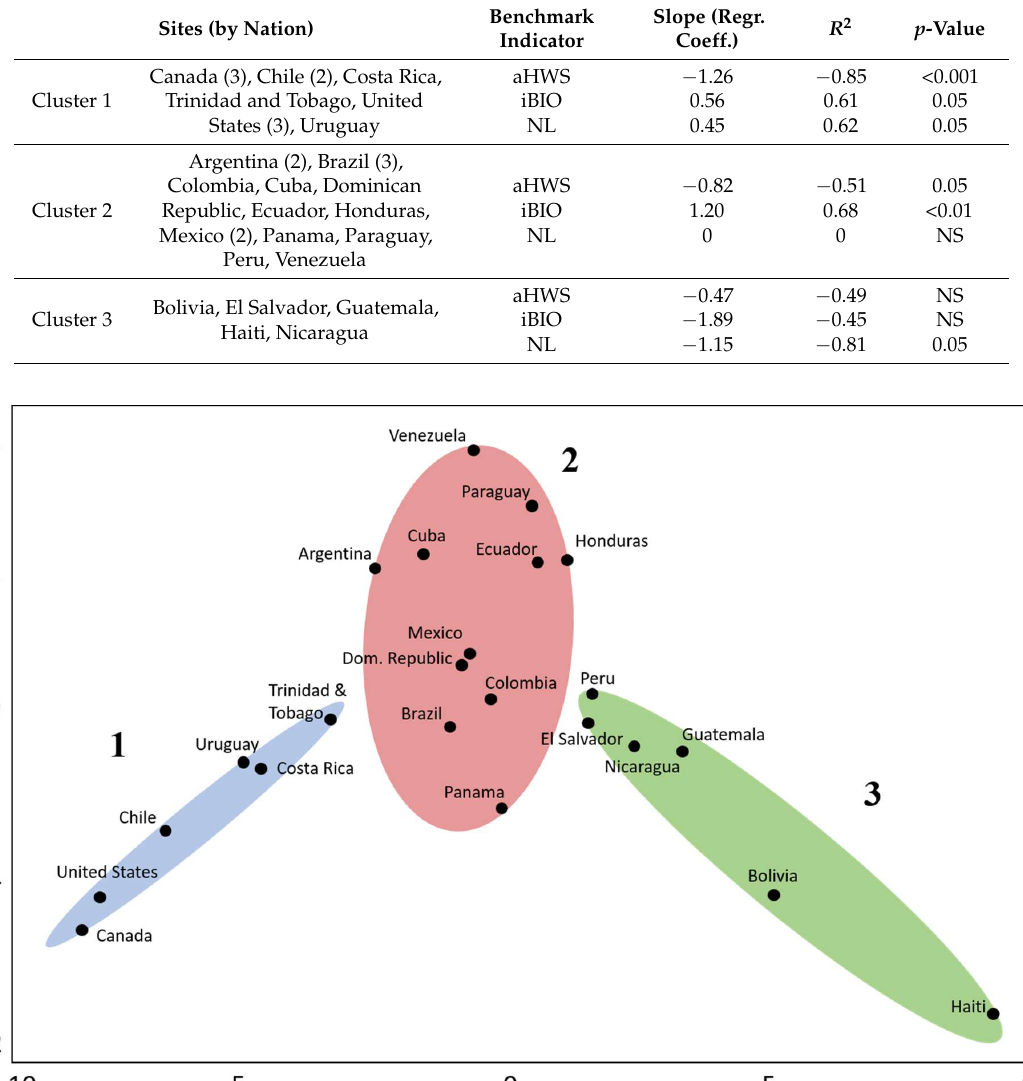
Table A2. Regression outcomes for Figure 7, with nations clustered by historical trends in GDPP, access to advanced sanitation (ACSAT), and Rule of Law (RL), where the regression coefficient (trend line slope).